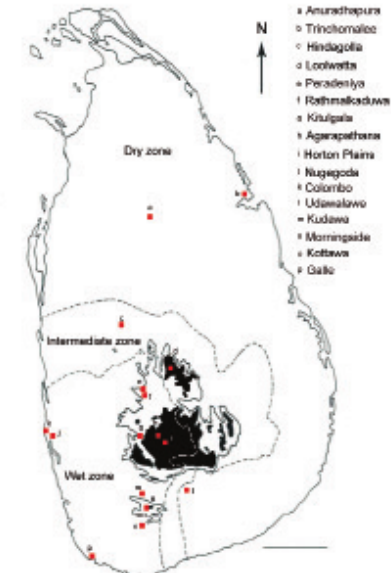
Figure 1: The map of Sri Lanka indicating specimen collection localities. Table 1 : The details of the rodent specimens subjected to phylogenetic